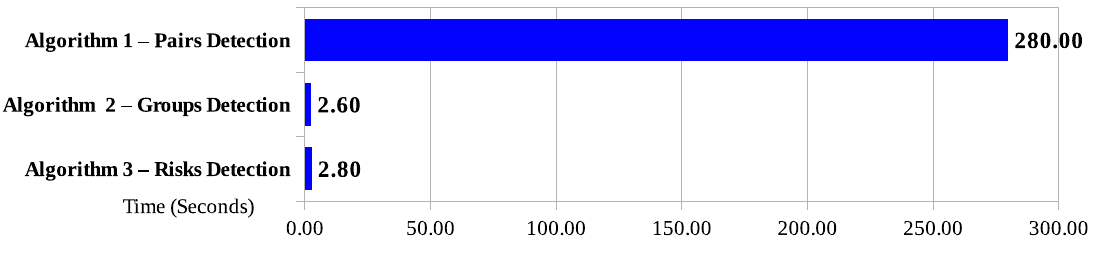
Figure 14. Response time by the algorithms. Source: the authors.